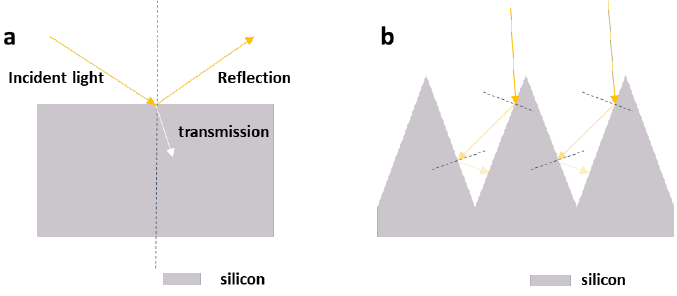
Figure 1. The reflection performance of ( a ) polished silicon and ( b ) black silicon.